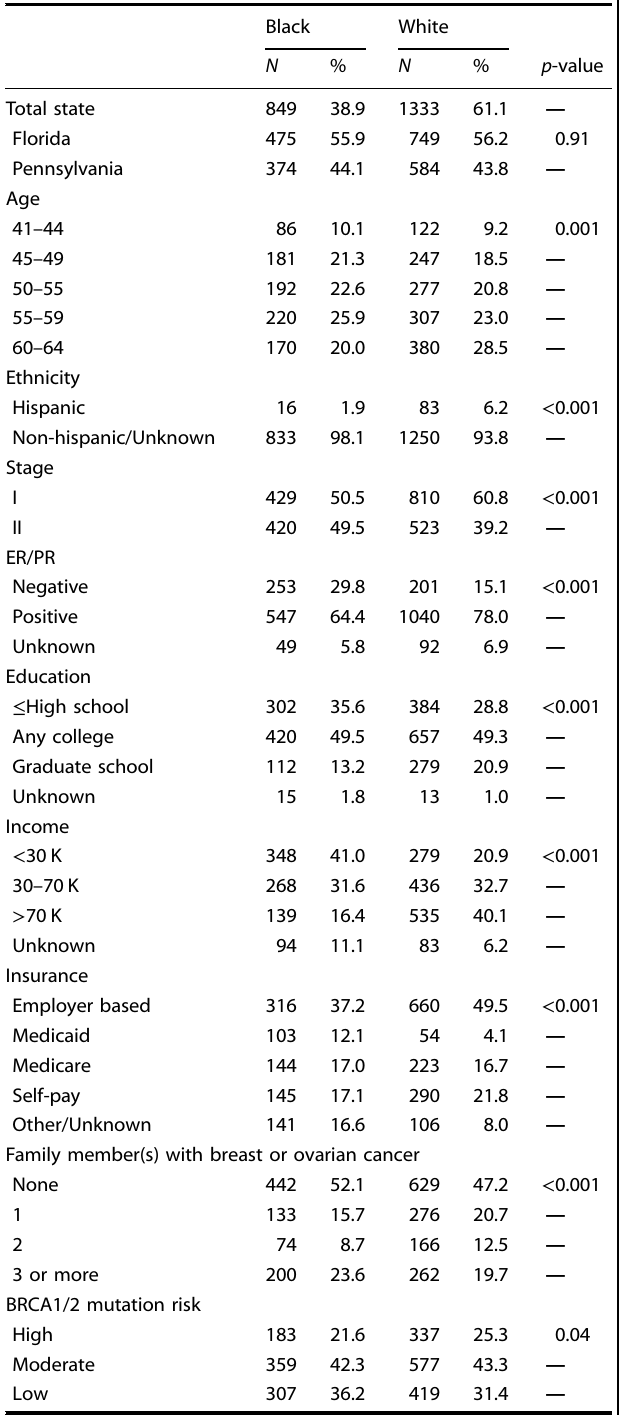
Table 2. Logistic regression models for contralateral